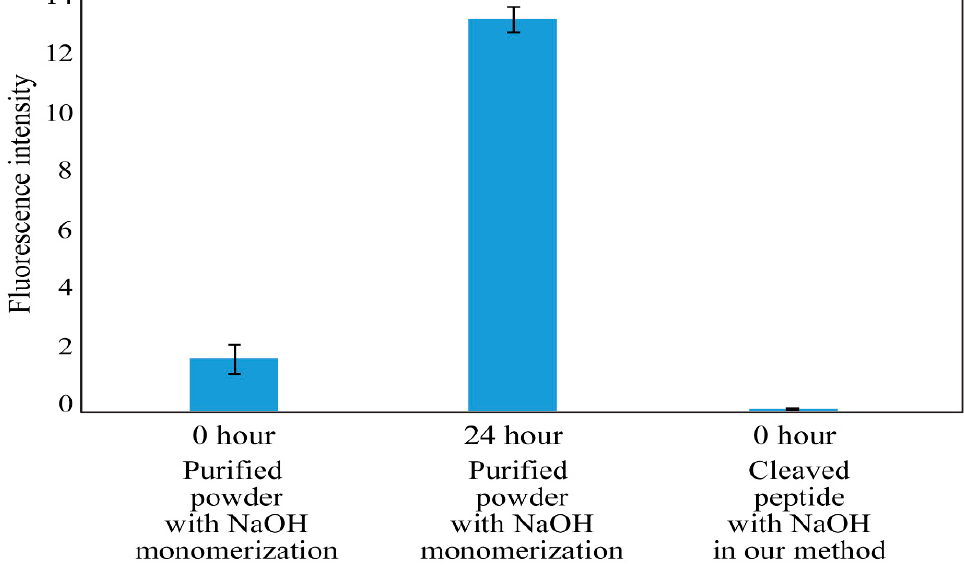
Figure 4. Thioflavin T (ThT) assay with A β (1-40) sample, 0 h or 24 h after preparation by dissolving the lyophilized powder in 250 mM NaOH for monomerization, and 0 h after cleavage from HMBA resin with NaOH by our method.